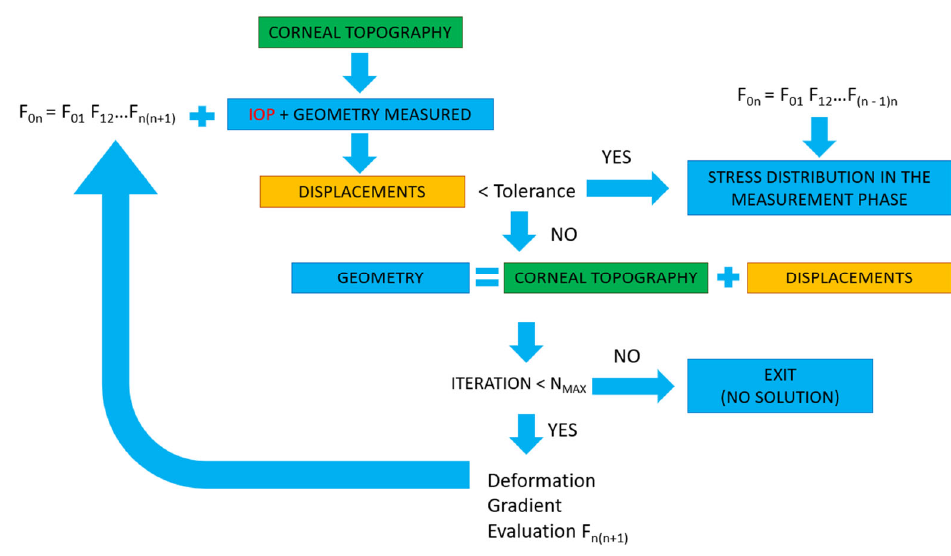
Figure 3. Calculation of stress distribution in measurement phase by prestress method.